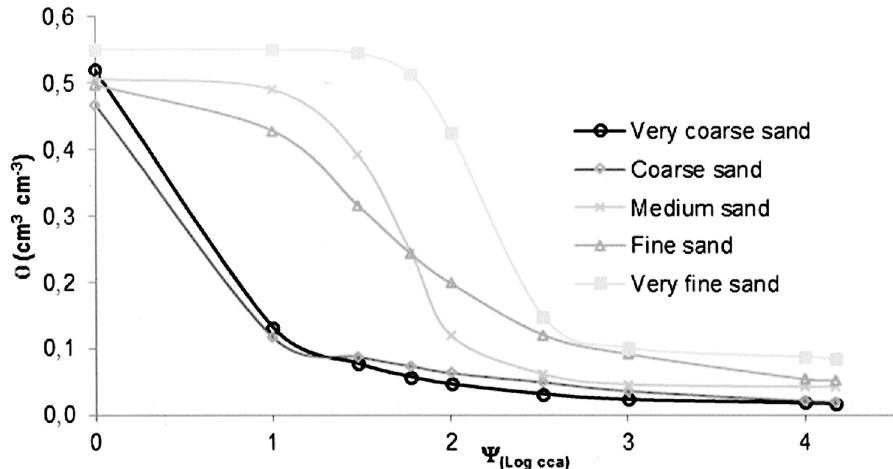
Figure 5 - Characteristics water retention curves in pure sand subfractions of sandy soils from the municipality of glória, Bahia state, Brazil. θ = volumetric water content; Ψ = applied tension; cwc = centimeter water